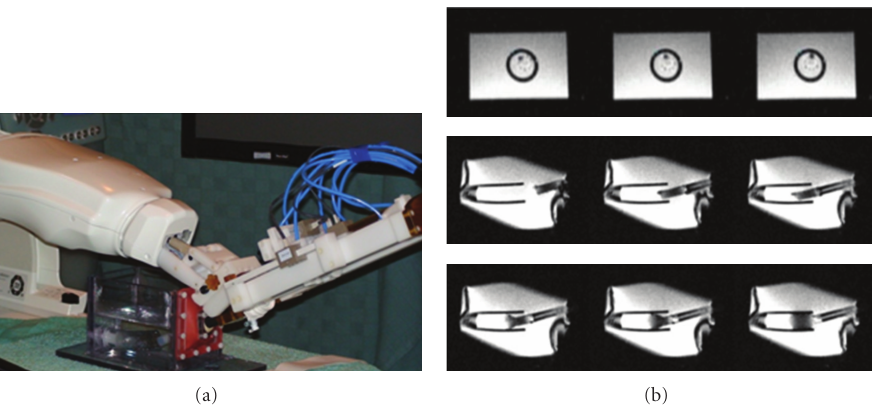
Figure 7: (a) Setup for system level evaluation on a phantom. The prototype of robotic valve deliver module is mounted on an Innomotion arm. (b) Sequence of MR images showing the progress of using our robotic system to place prosthesis under MRI guidance. First row shows the orientation adjustment of the prosthesis. Second row shows the position adjustment of the prosthesis. Third row shows the deployment of the self-expanding